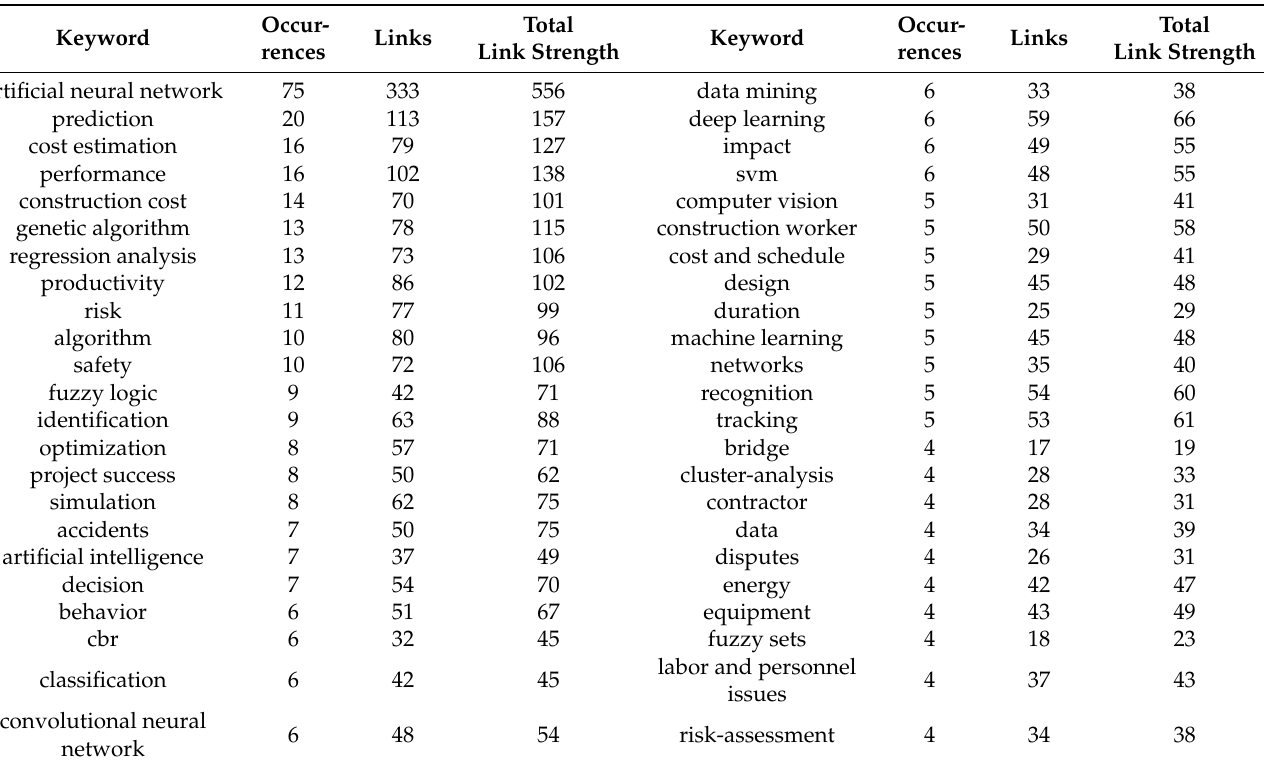
Table 2. Top keywords of existing research interests on ANN in CM.